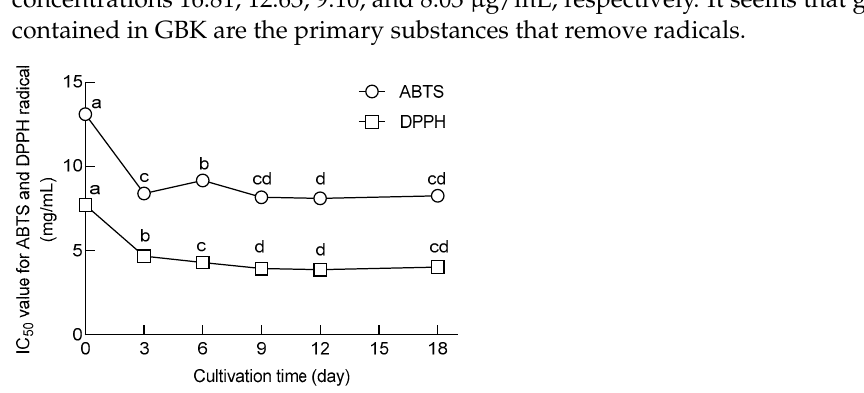
Figure 1. IC 50 values for ABTS and DPPH radicals during the fermentation of ginseng berry kom- bucha (GBK). Values are mean ± standard deviation (SD) of each group. Different letters indicate a significant difference at p < 0.05 (Tukey’s test). ABTS, 2,2 (cid:48) -azino-bis (3-ethylbenzothiazoline-6-sulfonic